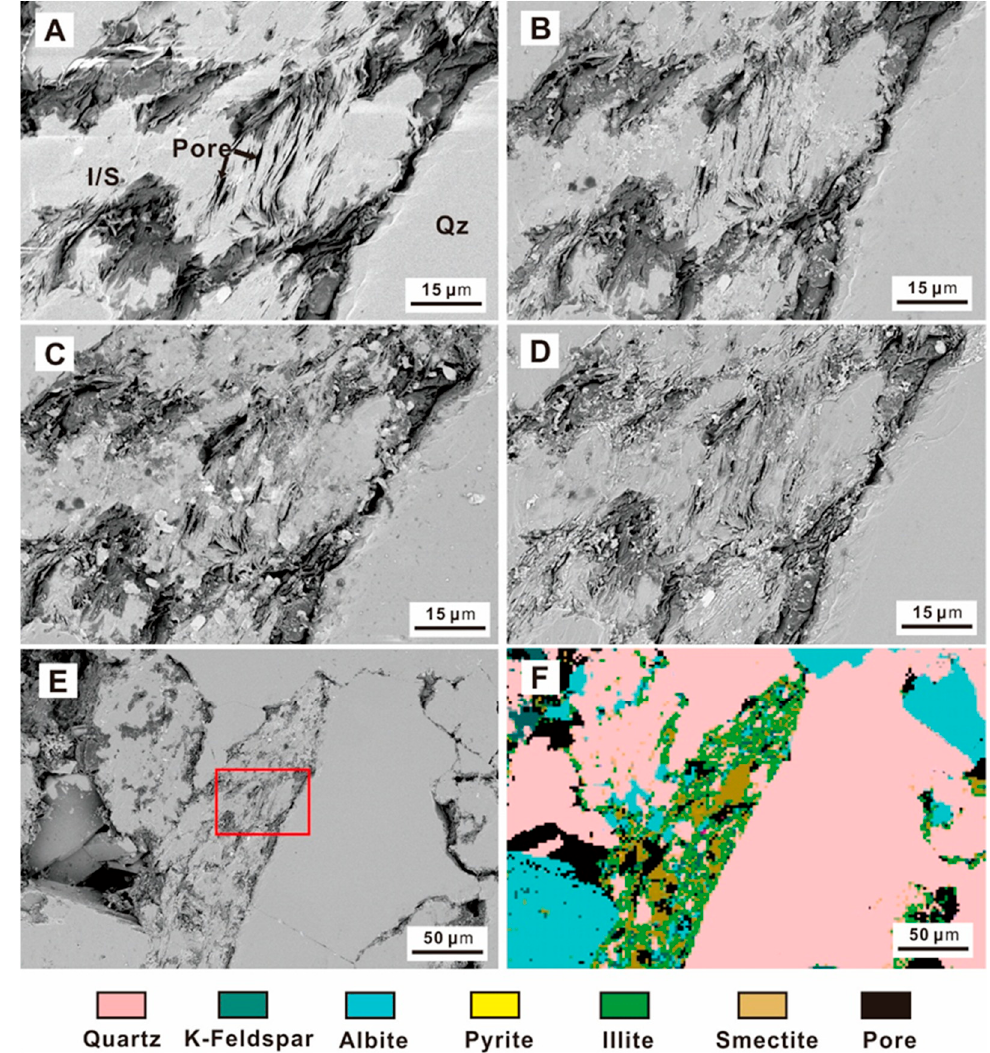
Figure 8. SEM images of the illite-smectite mixed layer during the experiment (Qz—Quartz, I/S— illite-smectite mixed layer) ( A ) initial sample; ( B ) After 24 h; ( C ) After 72 h; ( D ) After 432 h; ( E ) large- scale clay mineral map after 432 h; ( F ) QEMSCAN mineral analysis.